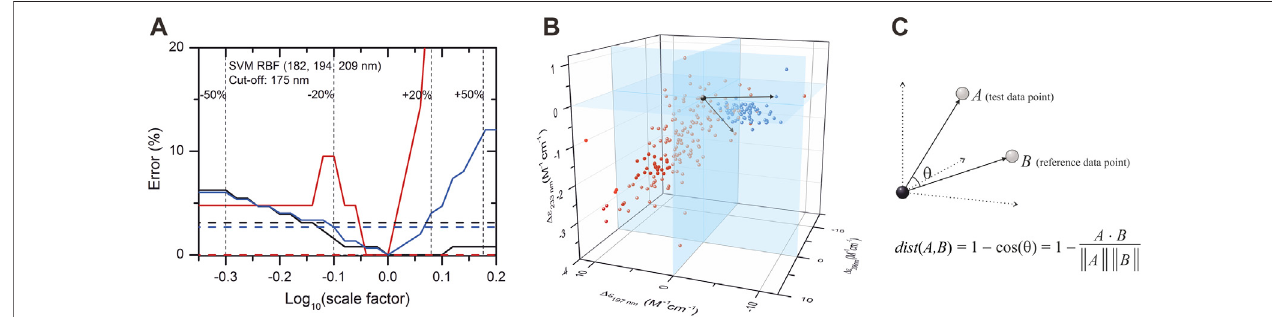
FIGURE3| Effectofconcentrationerrorondisordered – orderedclassi fi cationandintroductionoftheKNN-cosinemethod. (A) ErroroftheSVM – RBFalgorithmasa functionofthescalingfactoronthespectraofthedatabasewith175 nmcutoffareshownfordisordered(red)andordered(black)structures.Theglobalerrorisshownin blue. Dashed lines show the errors of classi fi cation using the KNN-cosine algorithm for disordered (red), ordered (black), and the overall error (blue). For convenience, ±20%and±50%changesintheconcentration(i.e.,inthescalingfactor)areshown. (B) ReferencepointsinthespacedeterminedbytheCDdatameasuredat197, 206, and 233 nm wavelengths and an example for vectors by using the KNN-cosine method. Red and blue points represent ordered and disordered proteins, respectively. (C) The distance metric of this KNN algorithm uses the cosine of the angle between vectors pointing from the origin to data points. The prediction is based onthelabels(ordered/disordered)ofthe fi rst10referencepointswiththelowest “ distance ” fromthetestpoint.Thedirectionandtheanglesofthevectorswillnotchange with scaling, that is, the method is independent of concentration errors.